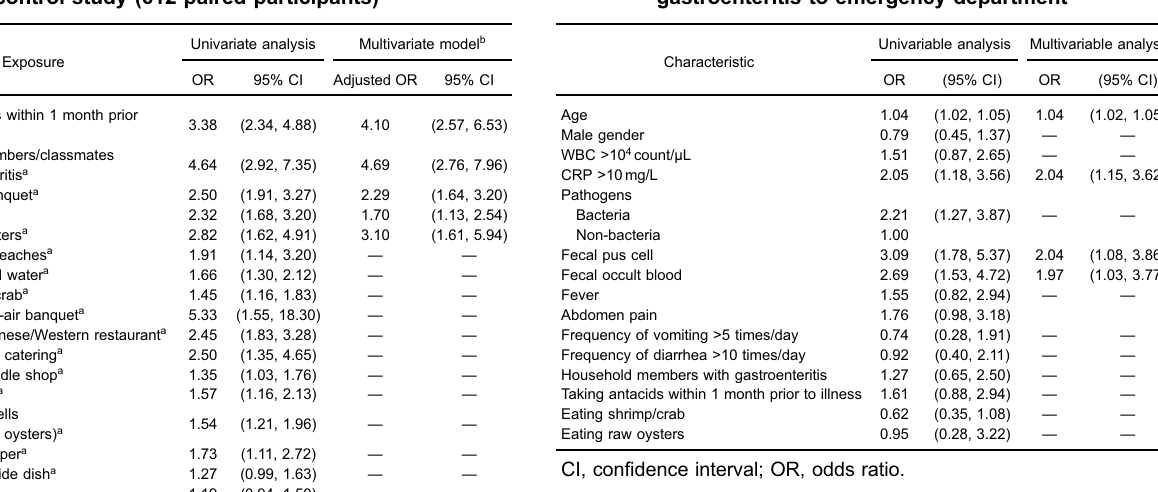
Table 4. Risk factors for admission of patients with acute gastroenteritis to emergency department